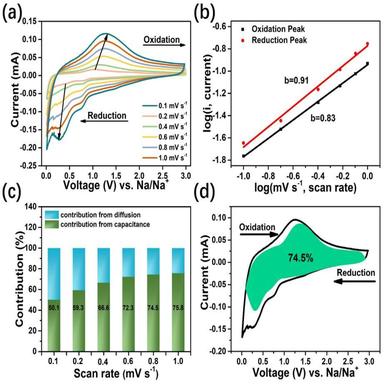
(a) CV curves of SnO2@FeOOH@C nanospheres at various scan rates, (b) relationship between log i and log v plots of anodic and cathodic peaks, (c) bar chart indicating the percent of capacitive contribution at various scan rates, (d) capacitive contribution to the charge storage at 0.8 mV s1 .